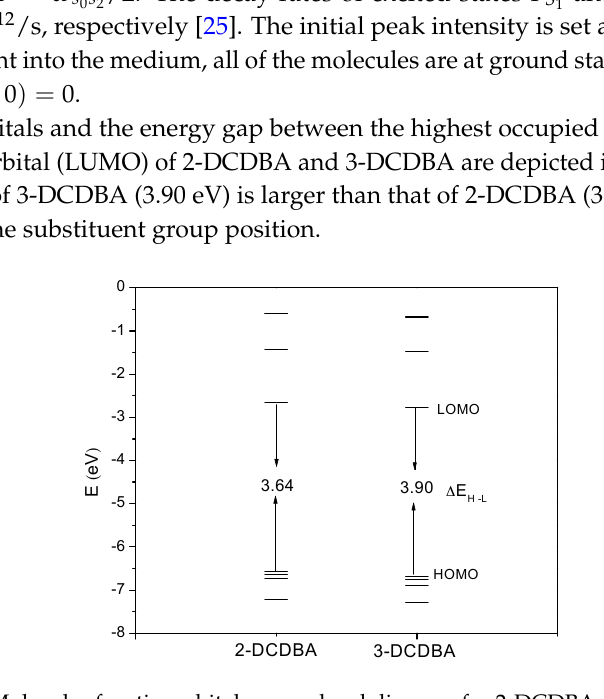
Figure 2. Molecular frontier orbital energy level diagram for 2-DCDBA and 3-DCDBA.